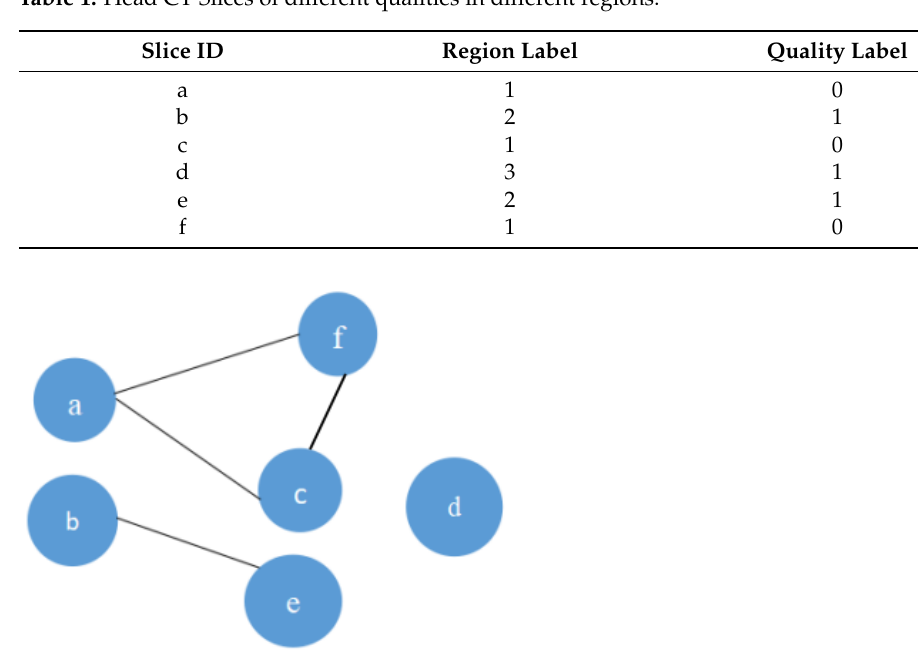
Figure 2. A schematic description of slice-level networks based on region and label consistency. Edges which are described by the straight lines are generated when the slices belonging to the same region label share the same quality label. Otherwise, the two slices are considered to be independent to each